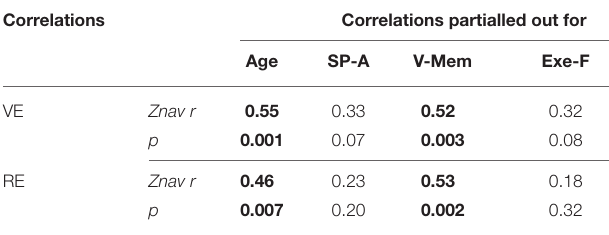
Values in bold reached the